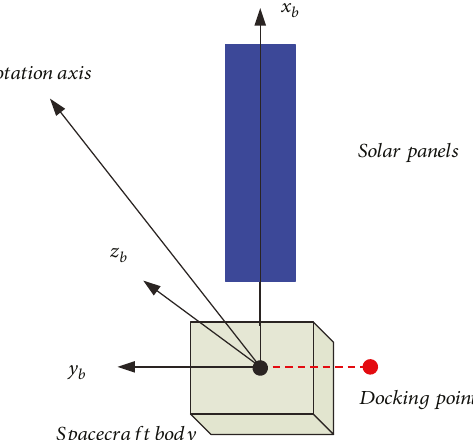
Figure 3: Failed spacecraft with solar panels deployed on only one